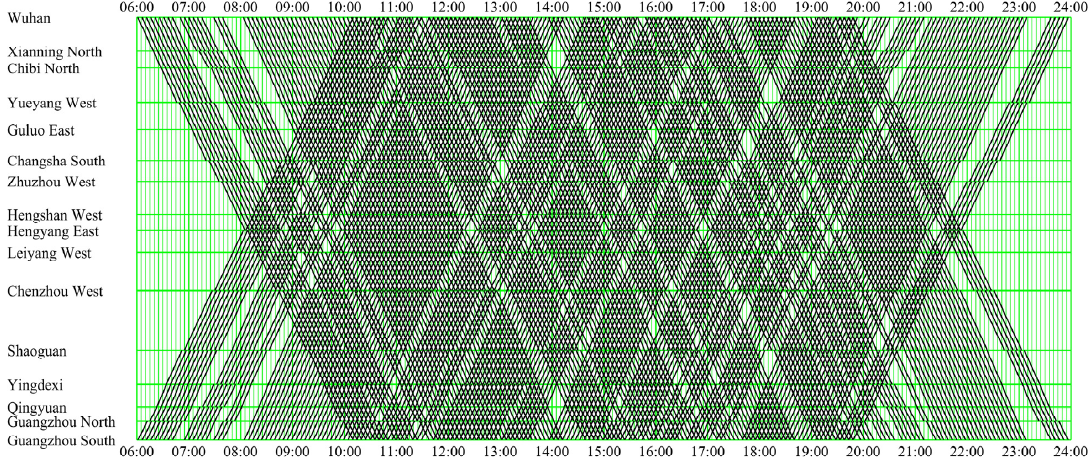
Figure 7. Train timetable ( |𝐿| = 100 ).